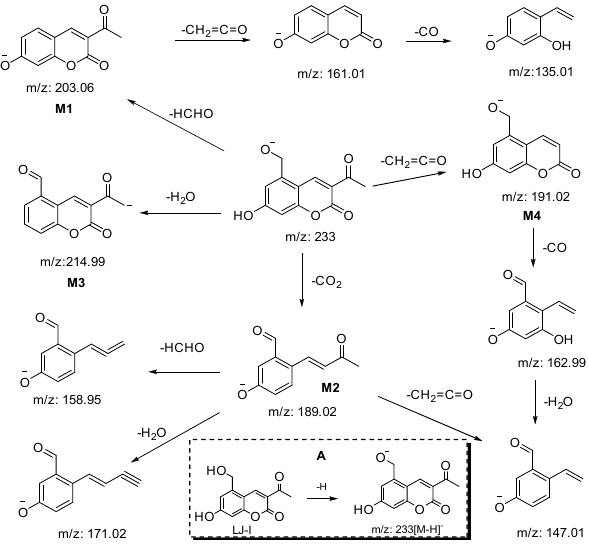
Figure 2. MS spectra ( a ) and MS 2 spectra ( b ) of AA-API, MS spectra ( c ) and MS 2 spectra ( d ) of the visible foreign solids (main peaks).